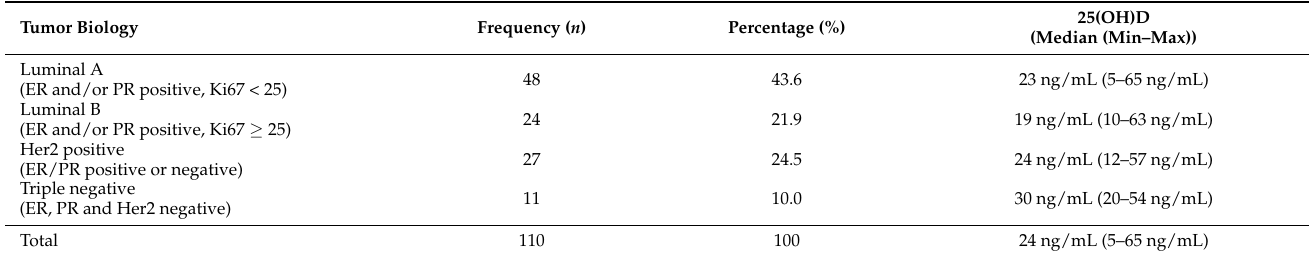
Table 1. Tumor biology and serum 25-hydroxyvitamin D (25(OH)D) levels. “ER” = estrogen receptor, “PR” = progesterone receptor.